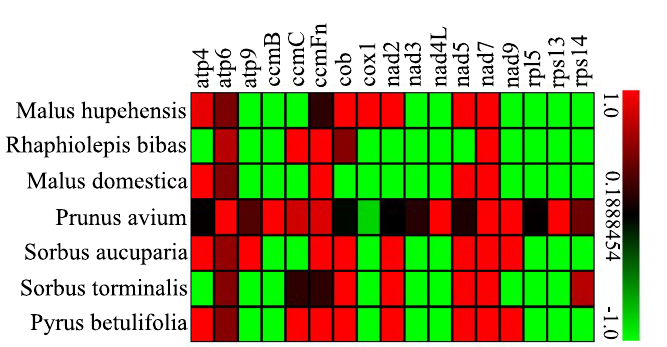
Figure 9. The Ka/Ks values of 17 protein-coding genes of P. serratifolia versus 7 species. The color in each box represents the Ka/Ks